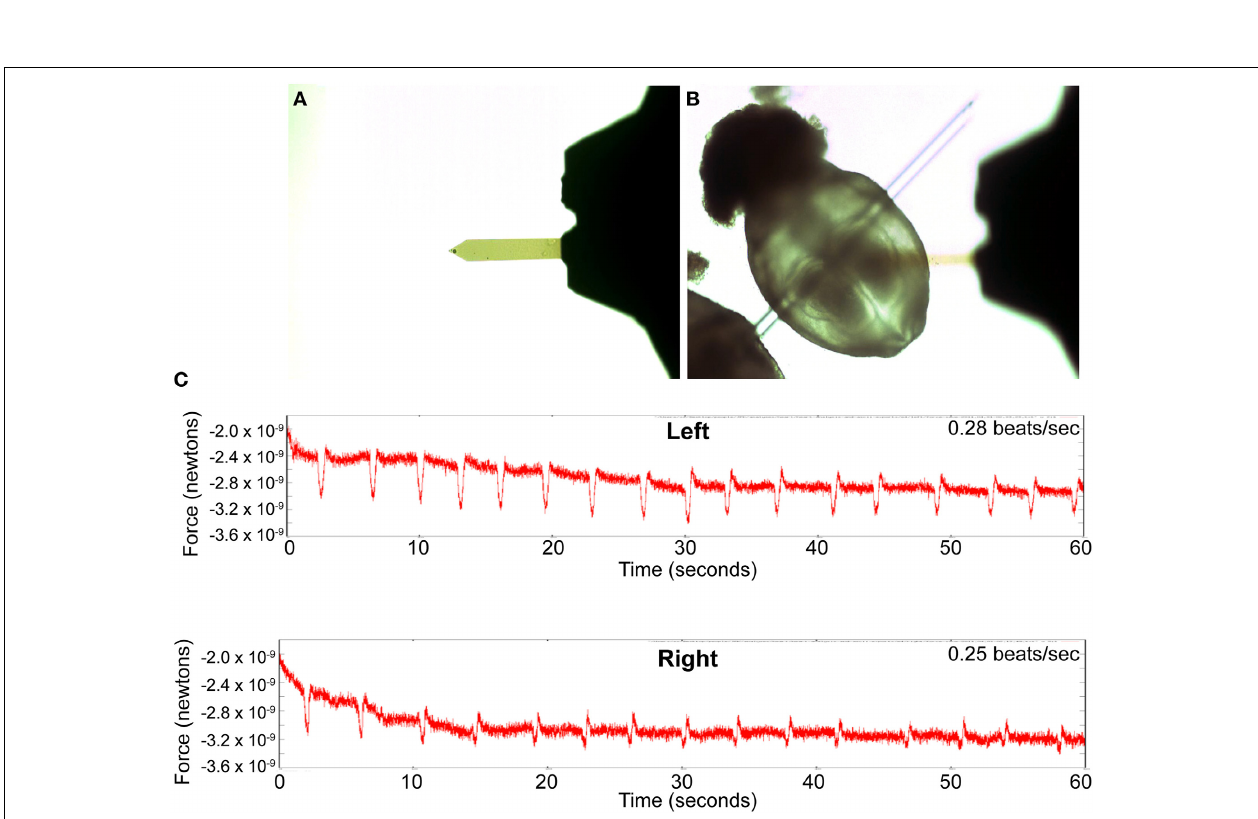
tissue that have large motion transients. Intensity vs. time plots from ROIs within these regions are used to determine the timing of contraction. Here the initial site of contraction is on the right side of the heart (right panel). The scale bar represents 100 microns. Also see Supplementary Movie 4 .